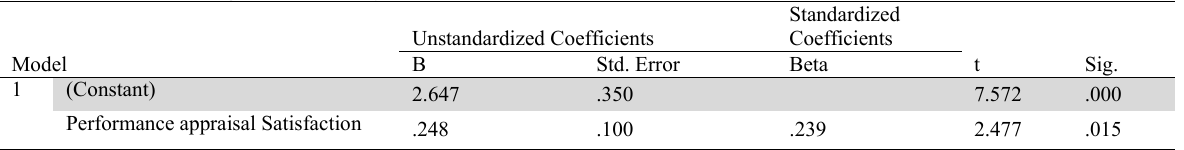
The results of the regression analysis